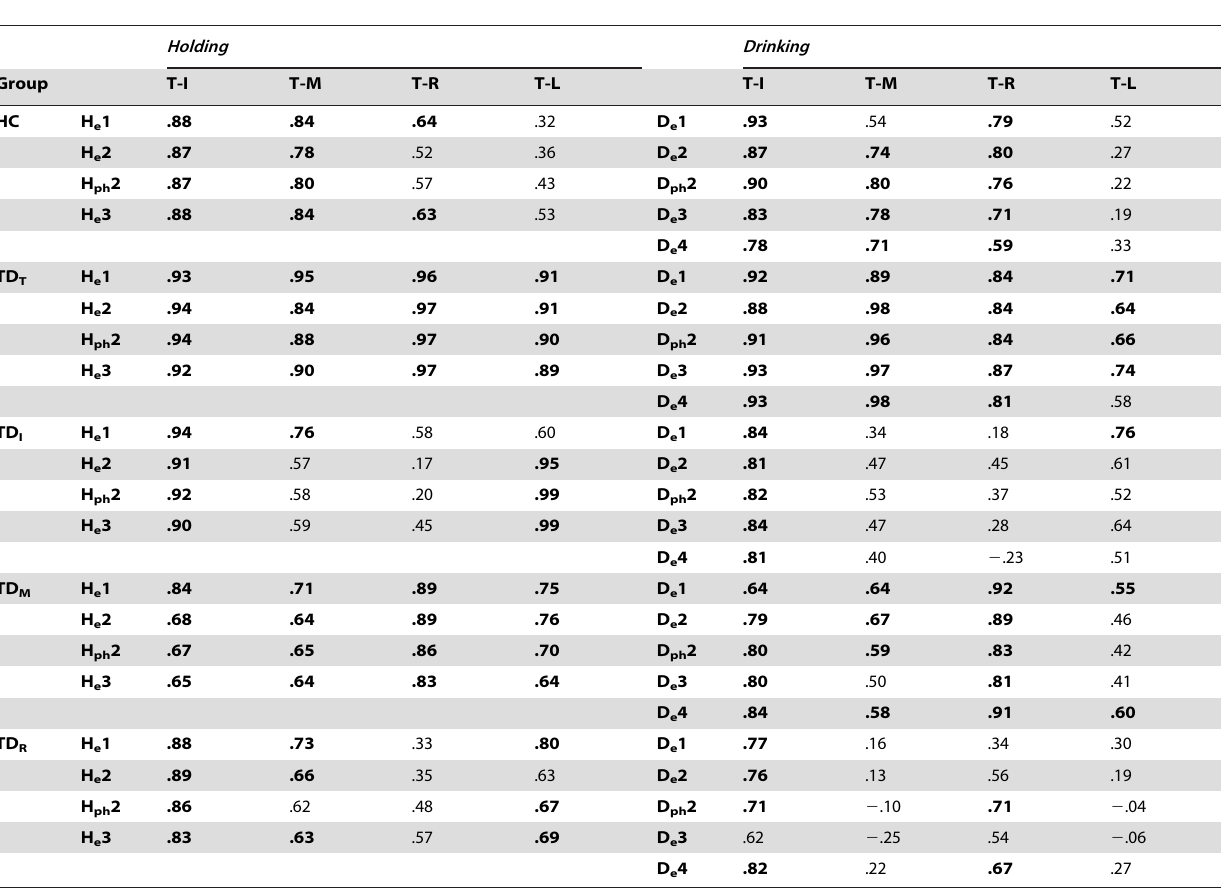
Table 2. Correlation coefficients between the radial (Fr) of the thumb and each of the fingers during holding and drinking tasks by HC and each TD